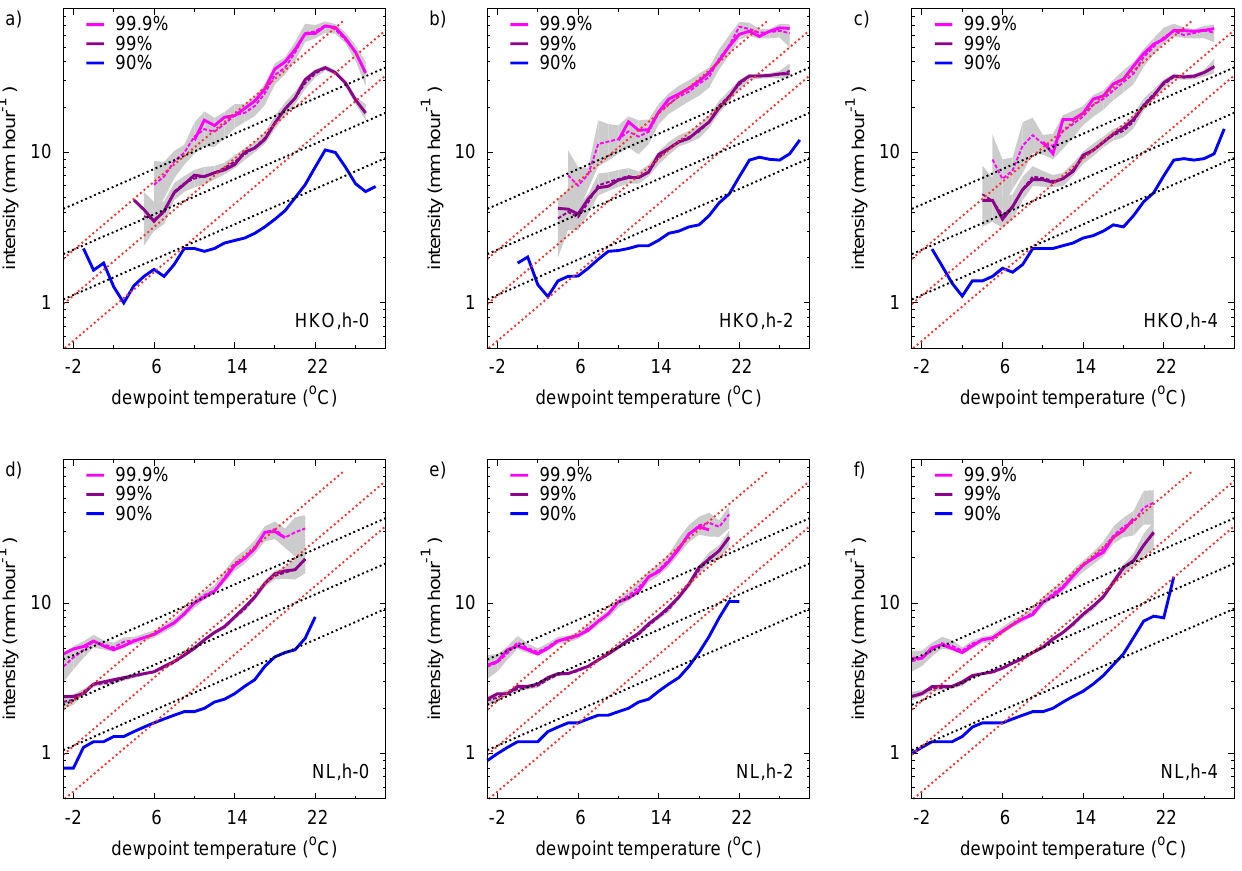
Fig. 2. Dependency of different percentiles of hourly precipitation extremes on dew point temperature taken 0 (h-0), 2 (h-2) and 4 (h-4)h before each precipitation event (upper panels: HKO; lower panels: NL). Lines and symbols are the same as in Fig.